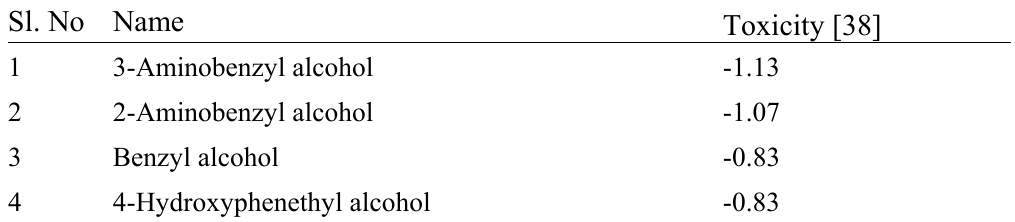
) of diverse compounds against T. 50